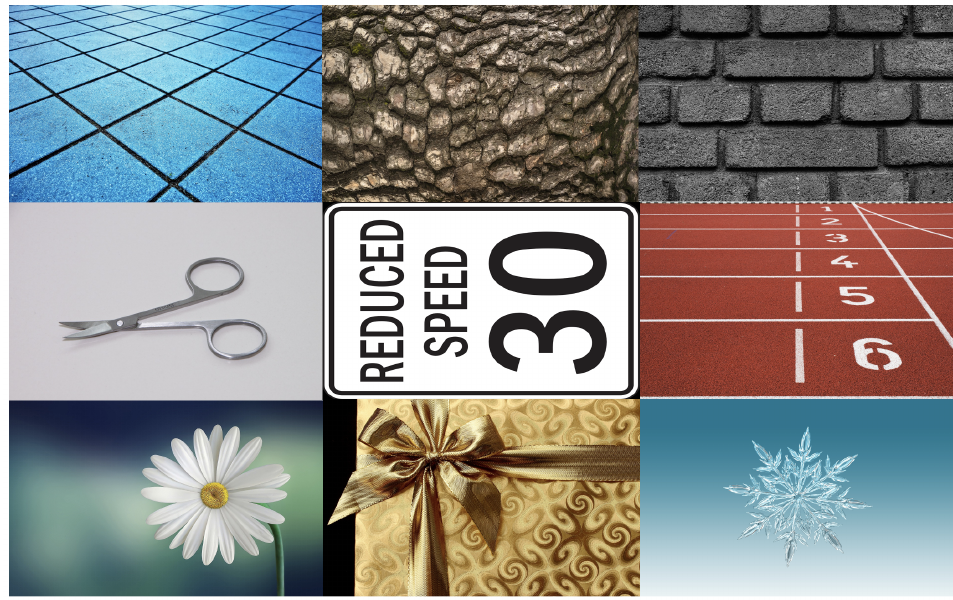
Figure 1. The 2D reference images, reproduced from the dataset of Kadyrova et al. [20]. From top left: tiles, wood, brick, scissor, speed sign, running track, flower, packaging, and snowflake images.